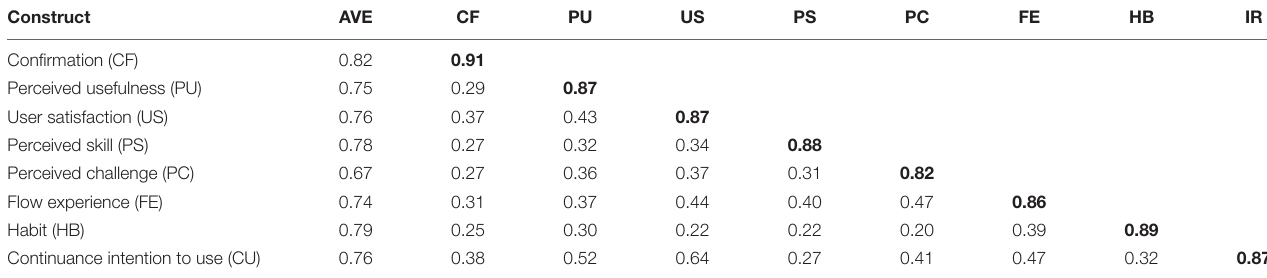
TABLE 1 | Correlations and average variance extracted (AVE).